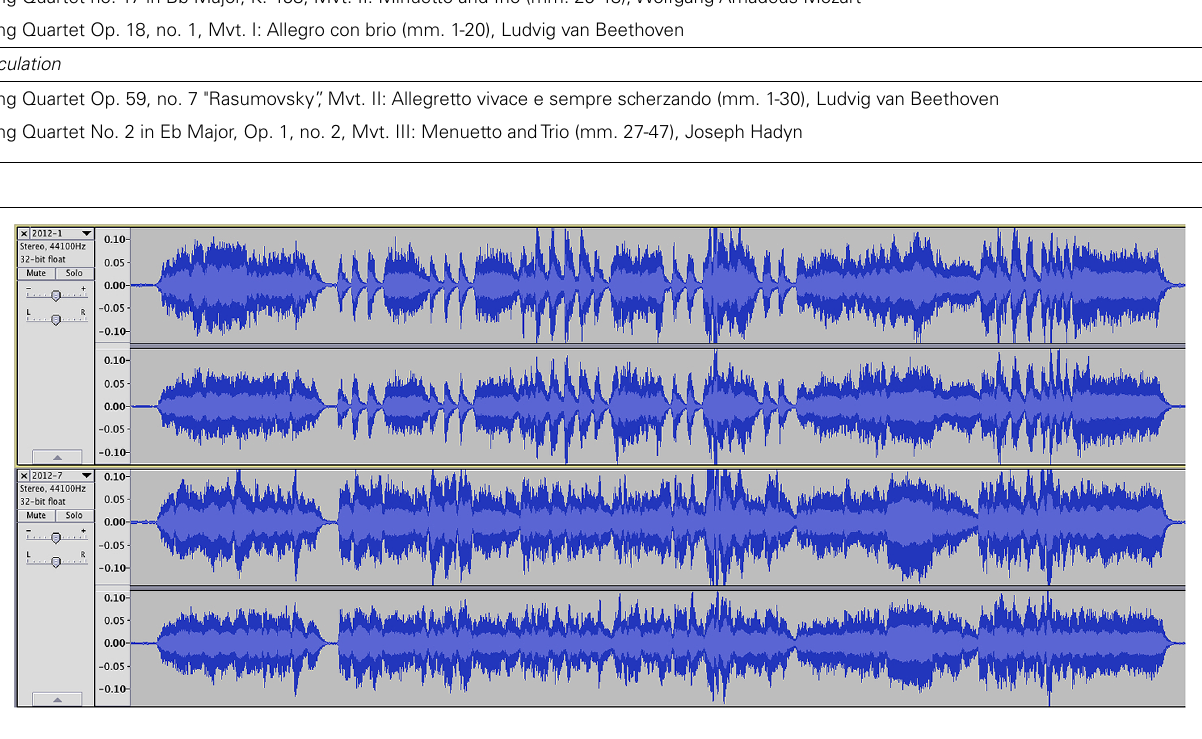
FIGURE 1 | Sample waveform for high- (upper) and low-contrast (lower) articulation